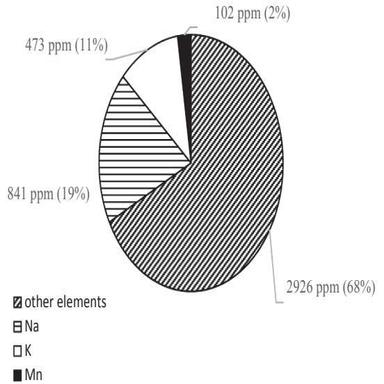
ICP plasma spectroscopy data concentrations of alkali metals in gypsum sample.